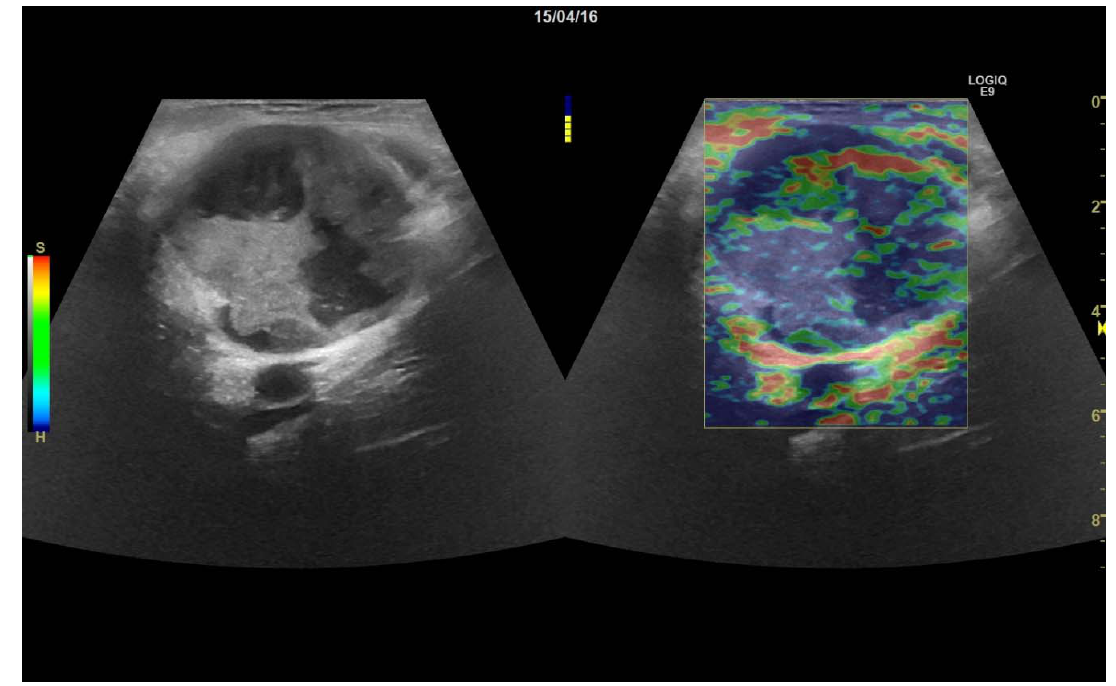
Figure 6. A 74-year-old female with metastasis of malignant melanoma. Ultrasound shows a highly heterogenous tumor, with both soft (red) and hard (blue) areas. The tumor was given a TES of 4 and a SR of 1.44.